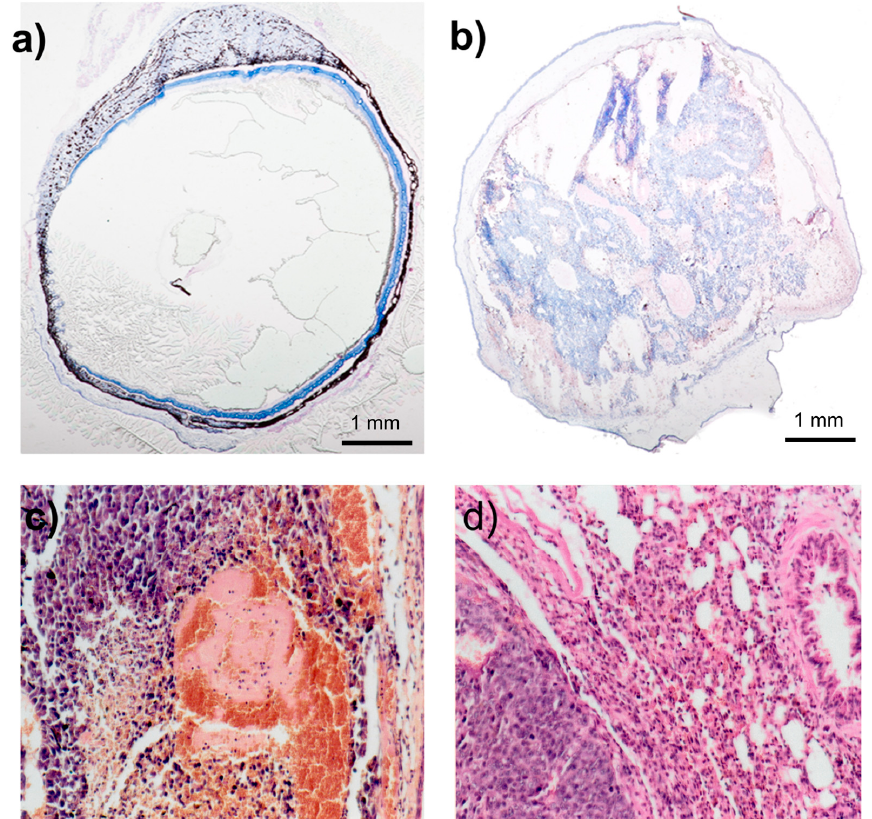
Figure 1. H&E-stained cross section through the hamster eye with BHM implanted into the anterior chamber. ( a ) Tumor grows in the anterior chamber only, and the choroid is clearly visible. Enucleated on day 9; ( b ) tumor masses fill up the whole eyeball, destroying the normal structures. The diameter of the eyeball is approximately 20% bigger. Enucleated on day 13; ( c ) H&E-stained tumor within the anterior chamber, magnification 360×; ( d ) H&E staining of the lung metastasis, magnification 360×. Three micro-CT images of the normal eyeball, medium-sized melanoma, and large melanoma are compared and shown in Figure 3. Figure 3c shows that the volume of the eye with the tumor is overdominated by a pathological vascularization net and a widespread tumor mass. All ocular structures are invaded by the melanoma, and the lens is not visible in Figure 3c. The vascular network revealed by micro-CT imaging is very dense in both the medium-sized and large tumors, particularly in the outer layers. The vasculature reaches up to 38% of the tumor volume. In the large tumor, both heavily vascularized and some avascular areas are seen (Figure 3b,c). Morphologically, irregular structures in the vascular network are observed, with highly varying diameters and lengths of vessels, with many local constrictions and dilatations, and with no visible hierarchy. The range of the tumor-vessel diameter was between 10 and 120 µm, although the upper limit might be an artifact of the algorithm, by counting two close vessels as one. The separation between the vessels was even more irregular. These parameter values spread out from 10 to 700 µm. However, a majority of the vessel-separation values cumulate between 100 and 300 µm (not shown).